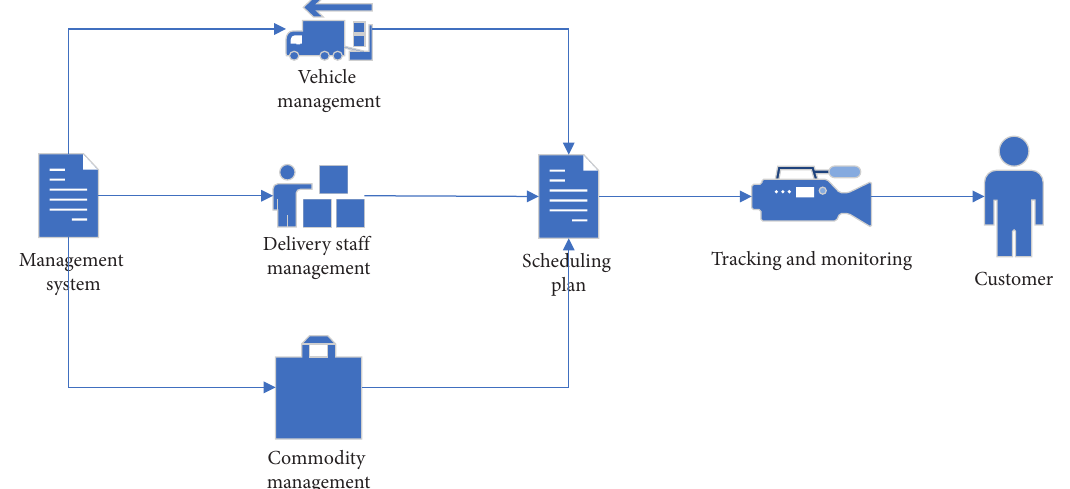
Figure 9: Scheduling management process.